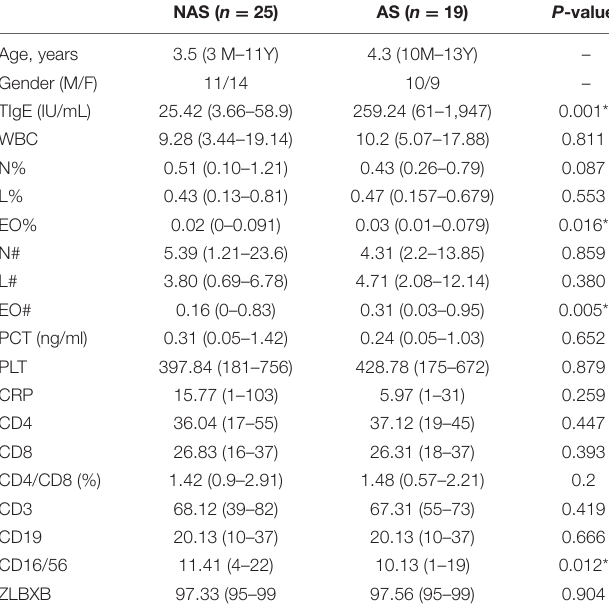
TABLE 1 | The biomarkers in NAS and AS groups and the difference between the two groups.